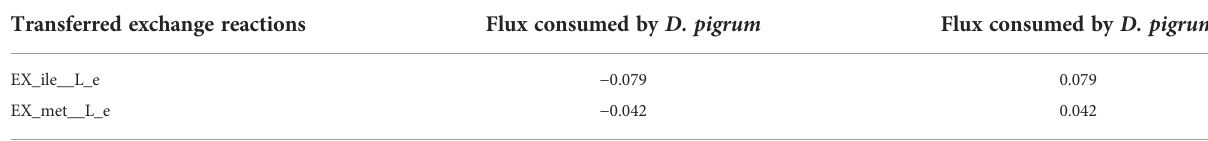
TABLE 6 The consumption and production of metabolites by S. aureus and D. pigrum in COOPM are computed in that way; D. pigrum has no growth in isolation (the fl ux values are rounded by the threshold ϵ = 10 − 3 ). Flux computed using the objective function a % MBR DP + (1 − a )% MBR SA Transferred exchange